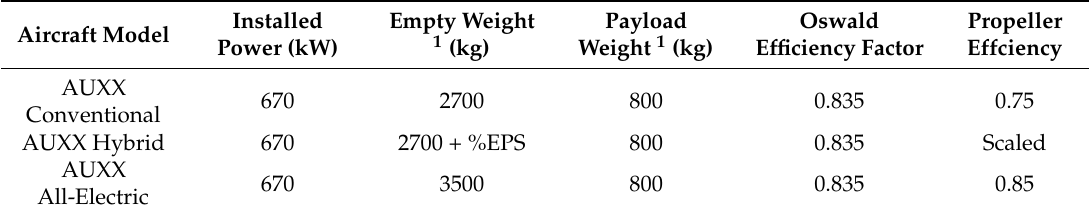
Table 2. Aircraft analytic model parameters.